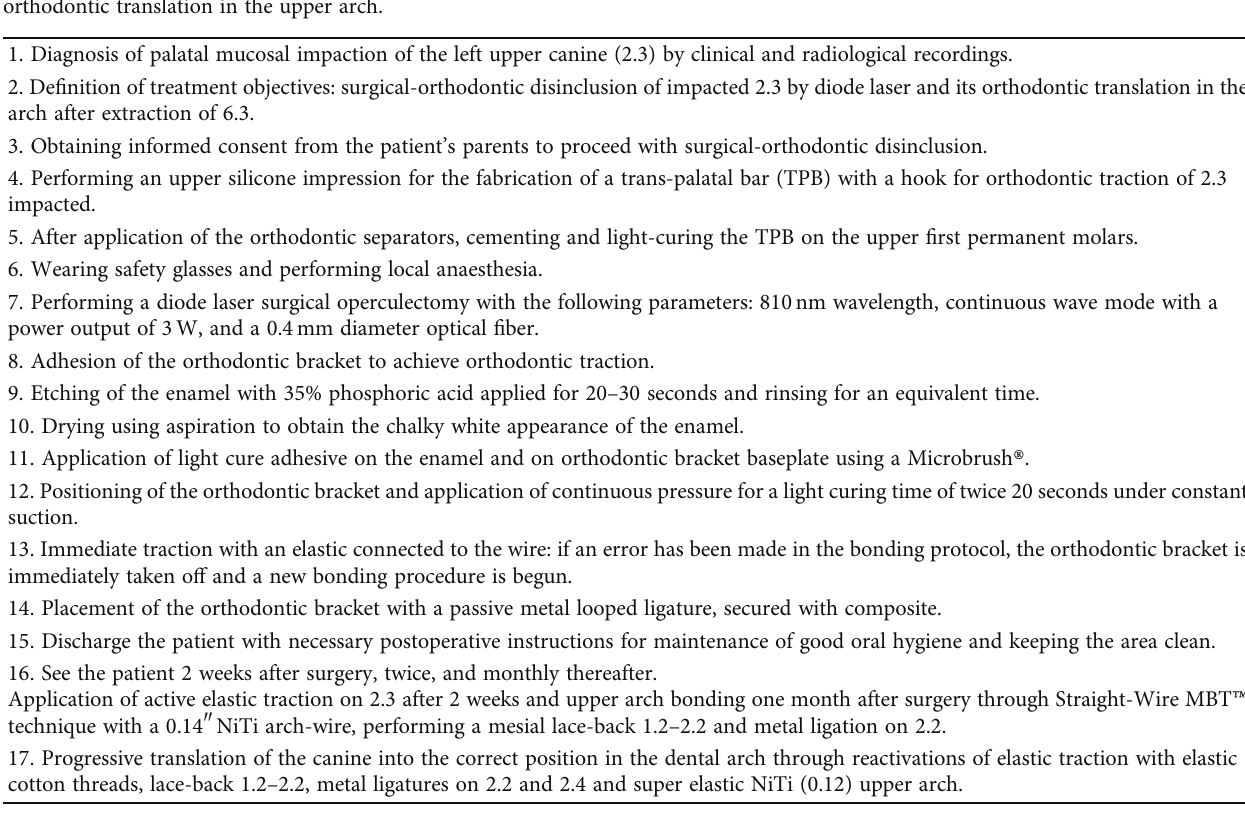
Table 2: Procedures checklist of surgical-orthodontic disinclusion of the left upper canine (2.3) in palatal mucosal impaction and its orthodontic translation in the upper arch.